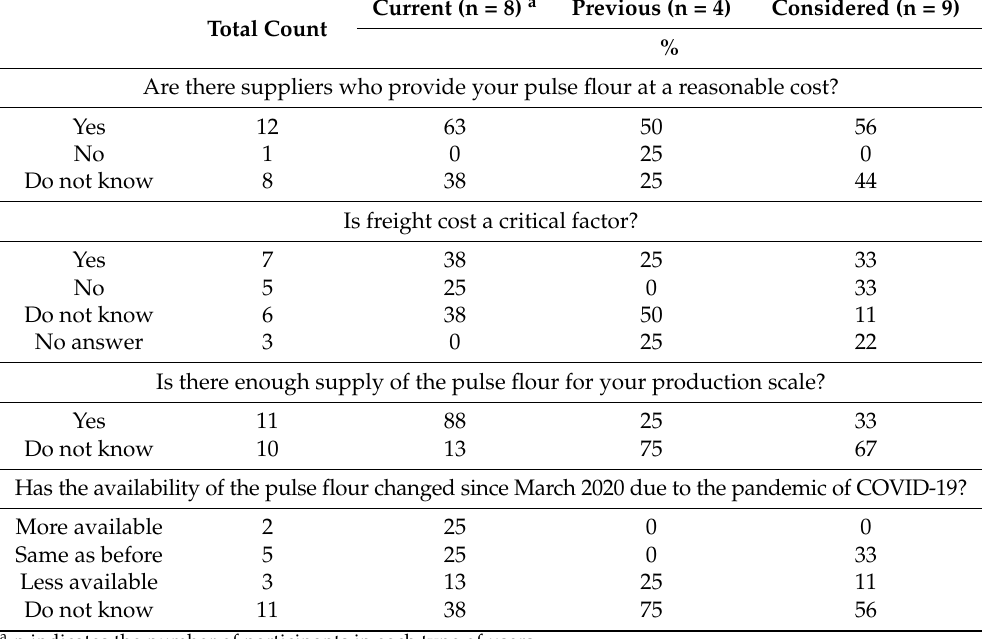
Table 12. The CPC users’ opinions on the supply and logistics of pulse flours and the availability of pulse flours during the pandemic of